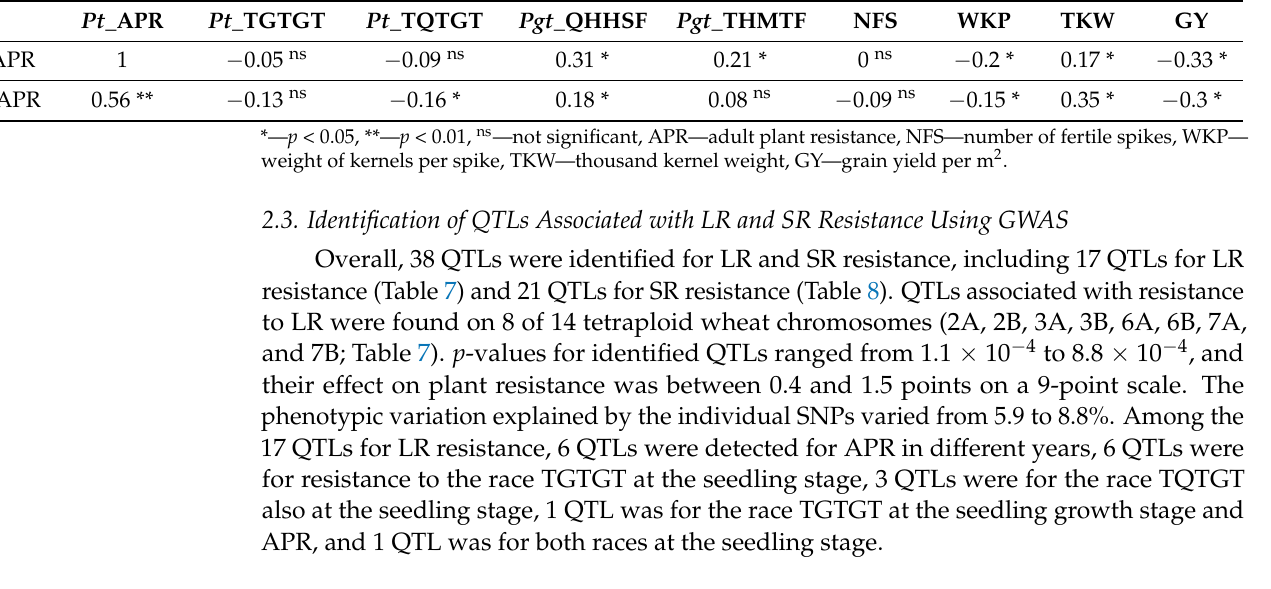
Table 7. QTLs for resistance to leaf rust (LR) identified in tetraploid